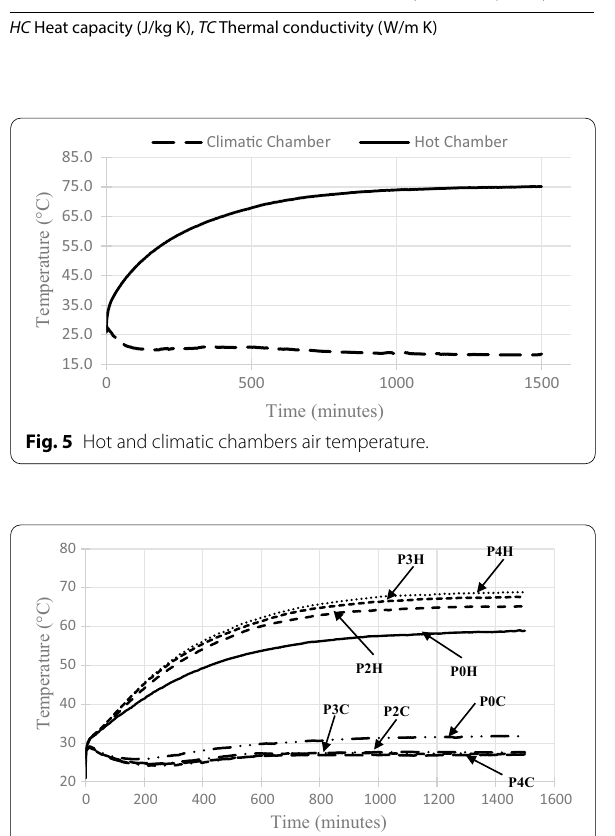
Fig. 6 Temperature profile of all specimen surfaces.